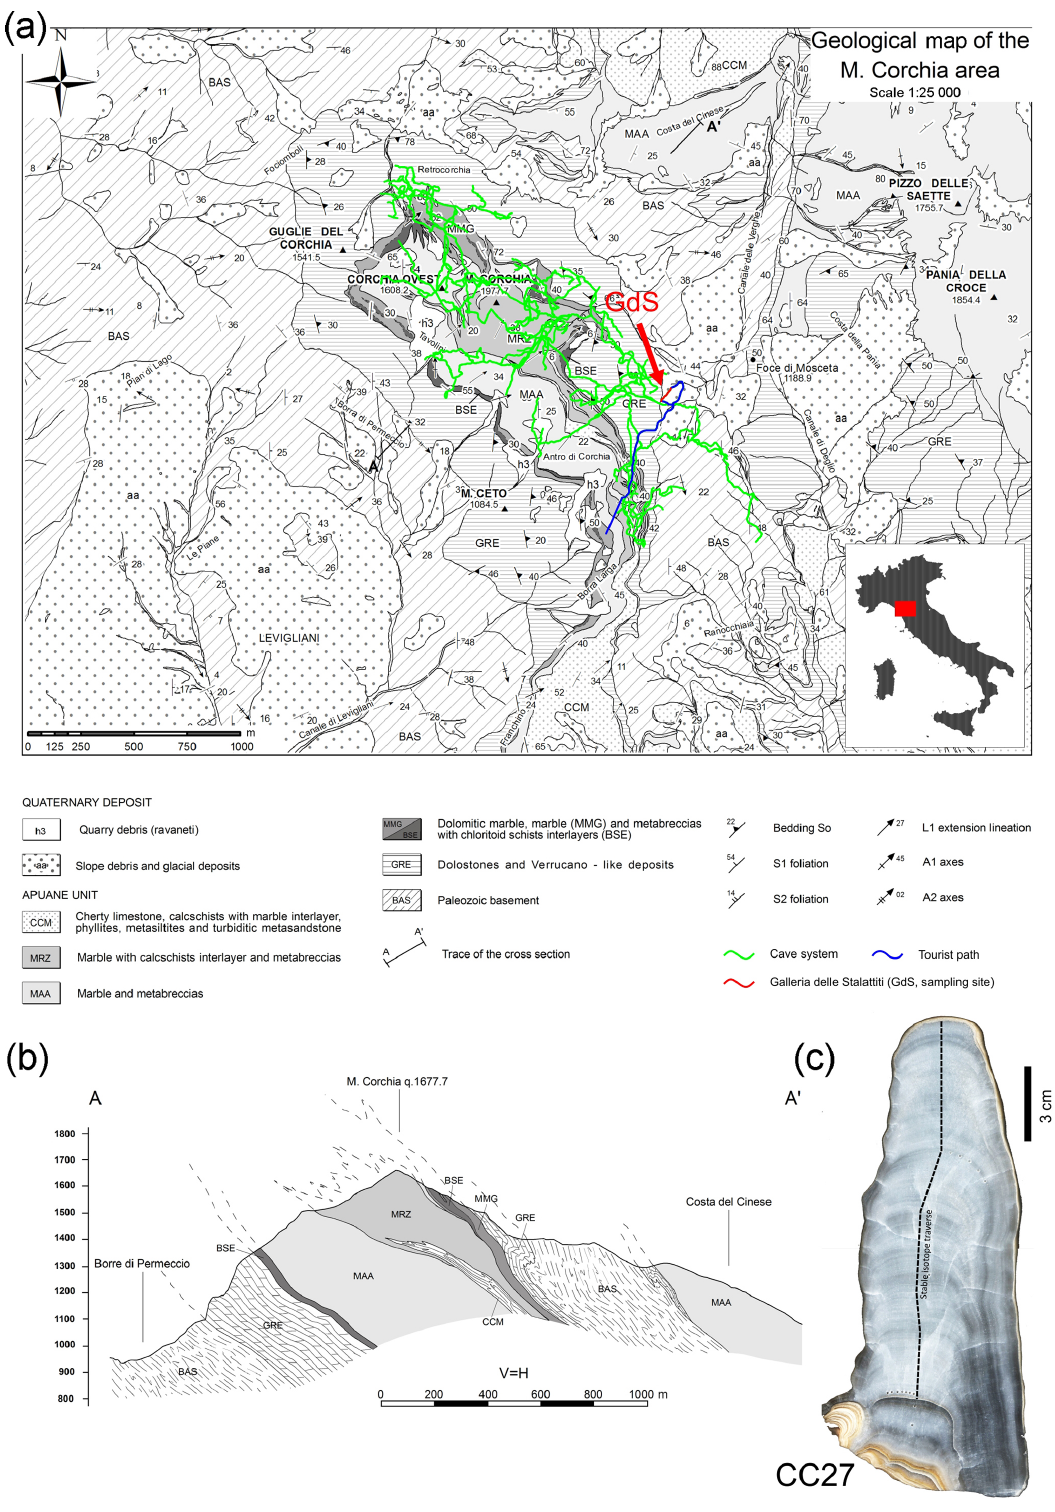
Figure 2. (a) Geological map of Mt. Corchia (modified after Piccini et al., 2008); (b) cross profile; (c) longitudinal section of the CC27